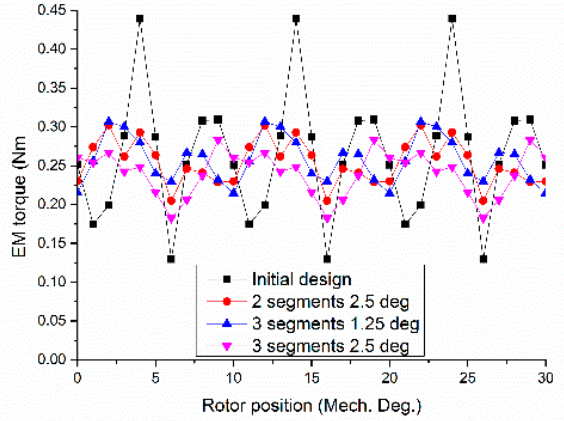
Figure 17. EM torque with three different machine designs.